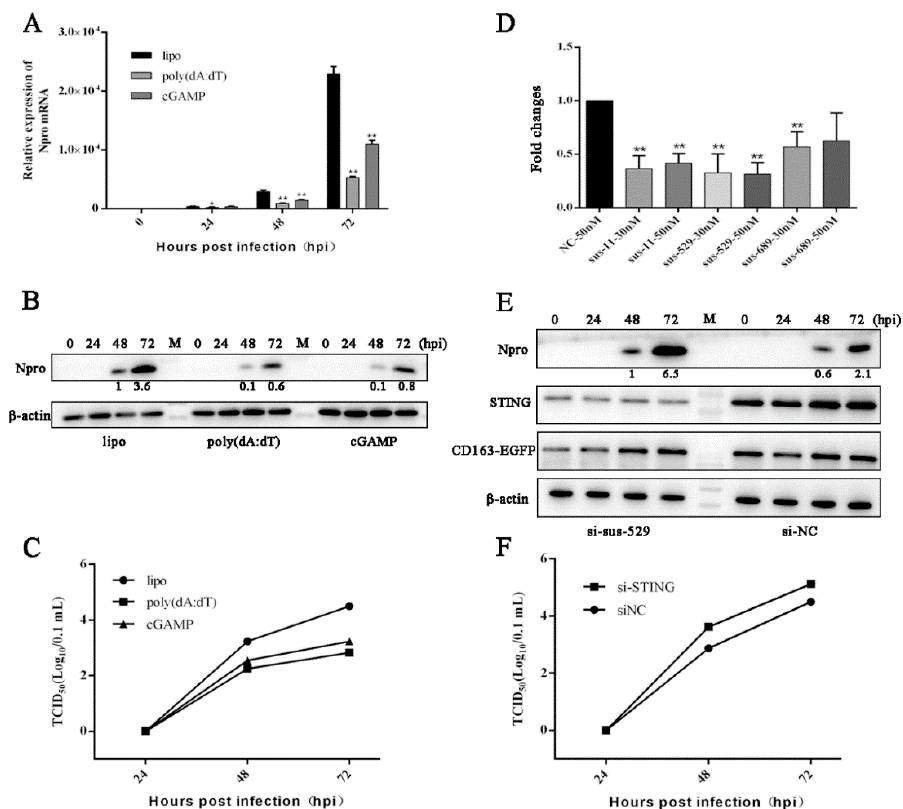
Figure 5. The PRRSV replication in porcine macrophages treated with agonists for cGAS-STING or with STING siRNA. ( A – C ) CD163-PAMs grown in 24-well plates were stimulated by transfection of poly (dA:dT) (1 μ g/mL) or 2 ′ 3 ′ -cGAMP (1 μ g/mL) using lipfectamine 2000 (lipo) for 24 h. Next, the stimulated cells were infected with PRRSV at a MOI of 0.1, for 0, 24, 48, and 72 h, respectively. The infected cells were assayed by RT-qPCR ( A ), Western blotting ( B ) and TCID50 ( C ). ( D – F ) CD163-PAMs in 24-well plates were transfected with the indicated siSTING or siNC by lipofectamine 2000 for 48 h, and STING gene expressions were quantified by RT-qPCR (D). CD163-PAMs were treated by transfection with siNC, and siSTING-529, respectively, for 48 h, followed by infection with PRRSV at a MOI of 0.1. Cells were harvested at 0, 24, 48, and 72 hpi, and the indicated proteins were detected by Western blotting ( E ). Viral titers in the supernatants were assayed by TCID50 ( F ). * p < 0.05, ** p < 0.01 versus the lipo/siNC control groups.